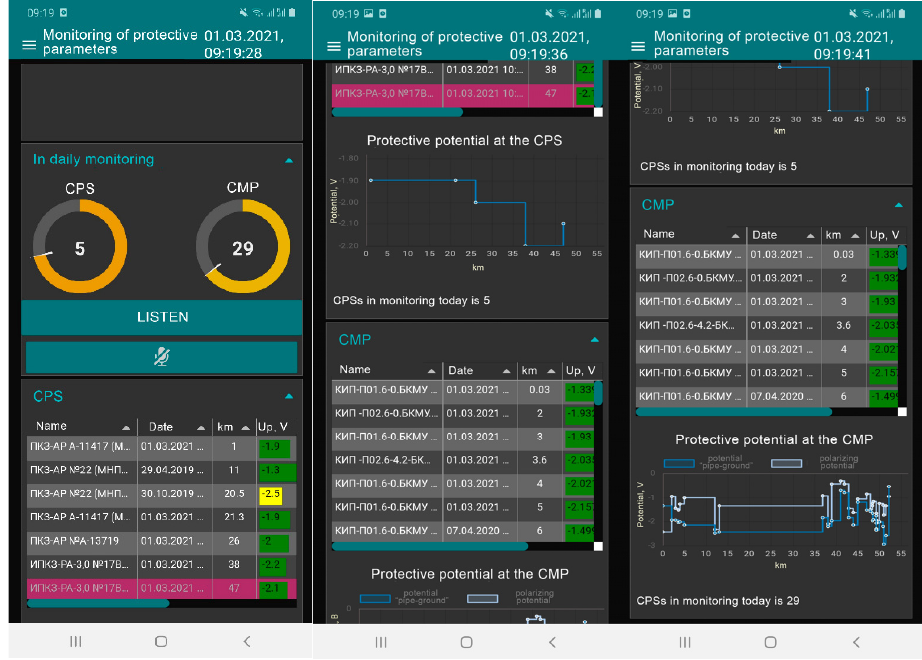
Figure 4. Dashboard with monitoring data on a mobile interface.